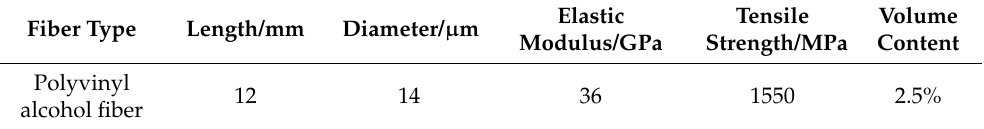
Table 3. Characteristic parameters of fibers in ECC.